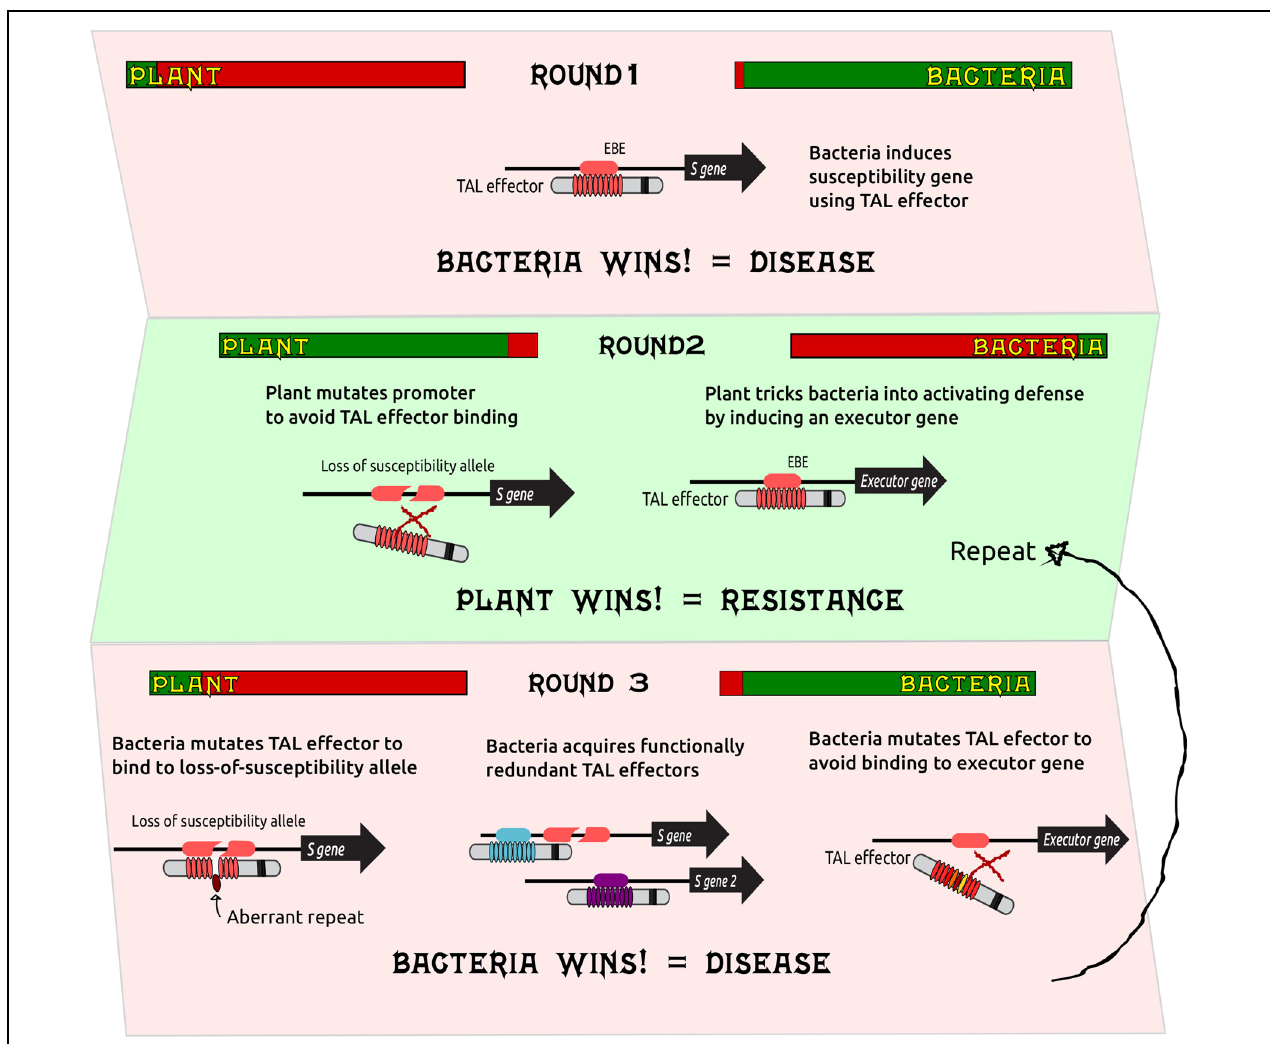
FIGURE 2 | A simplified model for combat involving bacterial TAL effectors and plant susceptibility genes. To cause disease, bacteria use TAL effectors that bind to the promoter regions of susceptibility ( S ) genes. The plant might defend itself against these effectors through mutations in the promoter that prevent binding of the TAL effector(s): so called loss-of-susceptibility alleles. Alternatively, plants can trick bacteria into inducing defenses via an executor gene. Bacteria can in turn counter by mutating TAL effectors to recognize the loss-of-susceptibility alleles using for